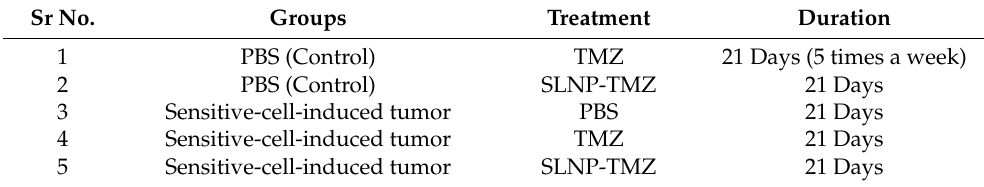
Table 1. Experimental groups for in vivo analysis of the cytotoxic potential of SLNP-TMZ and free TMZ. Sr No. Groups Treatment